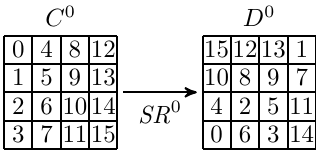
Figure 6: Permutation SR 0 used in the practical experiments.